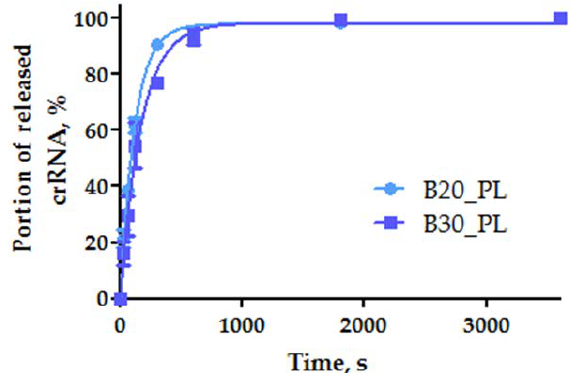
Figure 4. The effectiveness of releasing fluorescent crRNA_Flu immobilized on SWCNT surface through the auxiliary pyrene-modified PC-DNA upon UV irradiation (365